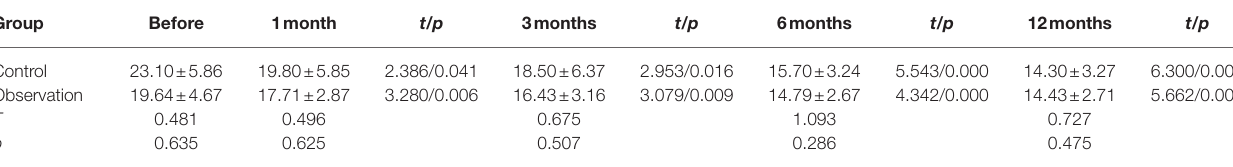
TABLE 3 | The serum TB levels in the two groups before and after ABMI (mean ± SD, μ mol/L). Group